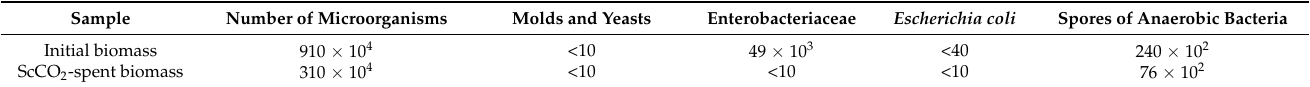
Table 2. Microbiological profile of Tetradesmus obliquus biomass: initial biomass and biomass after CO 2 supercritical extraction (ScCO 2 -spent biomass). Results are expressed in colony-forming units (cfu) per g (initial and spent